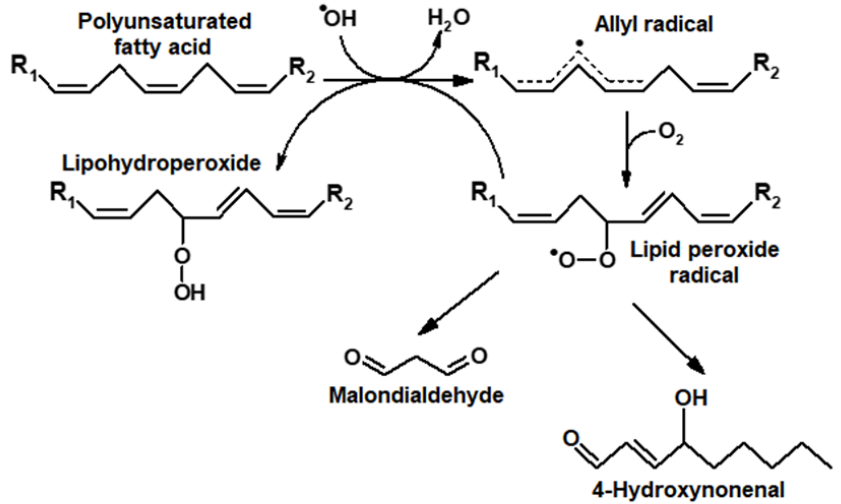
Figure 1. Formation of primary (LOOH) and secondary products (carbonyl compounds) during the induction of oxidative stress by oxygen radicals (ROS).